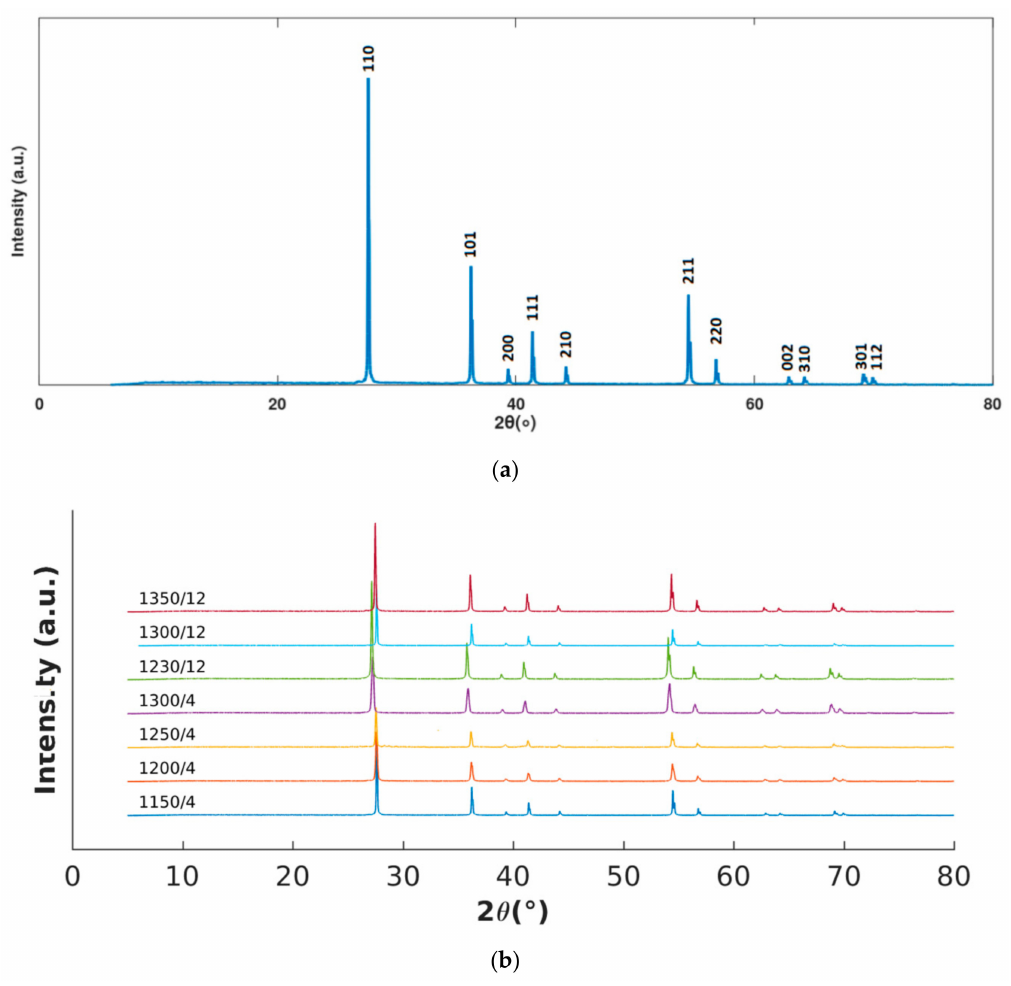
Figure 1. Pattern: ( a ) TiO 2 samples sintered at 1300 ◦ C for 12 h (1300 / 12). ( b ) XRD of all